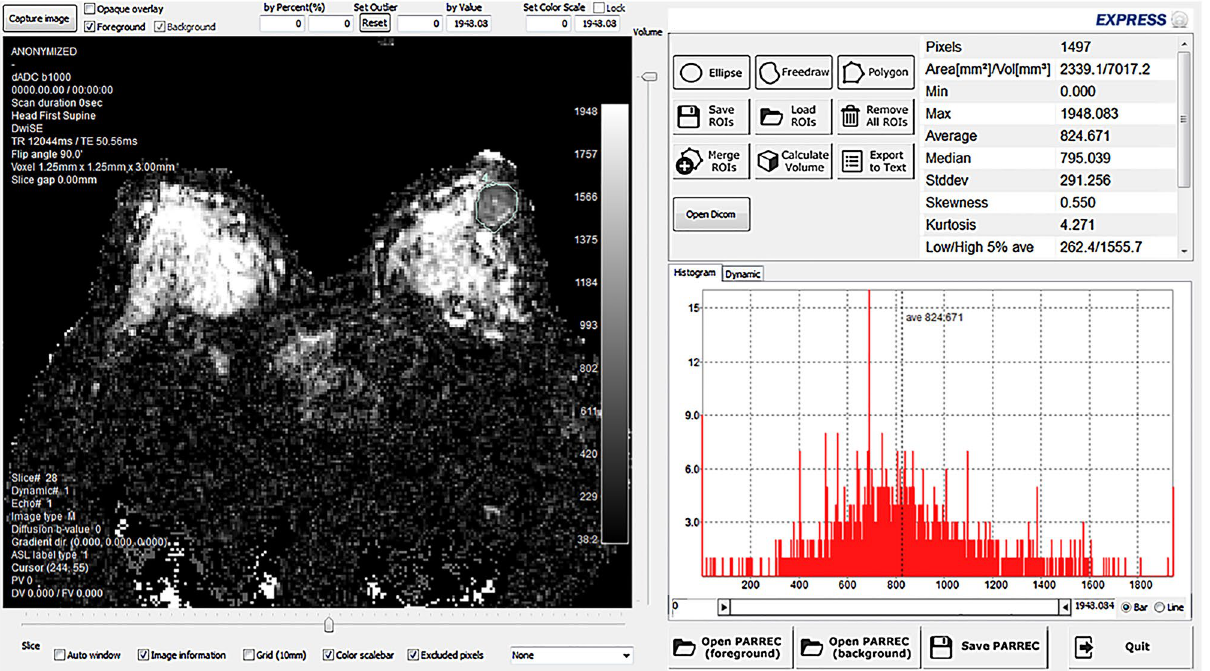
Figure 3. Analysis of ADC histogram of invasive breast cancer at subareolar region of left breast. The segmentation of tumor in ADC map was performed by manually drawing the ROIs in every single slice encompassing the entire tumor. The location of tumor was determined by referring to DWI and early dynamic phase images if the tumor location was confusing or not definite. After all ROIs were manually drawn, they were merged as VOI. Histogram analysis was performed on the